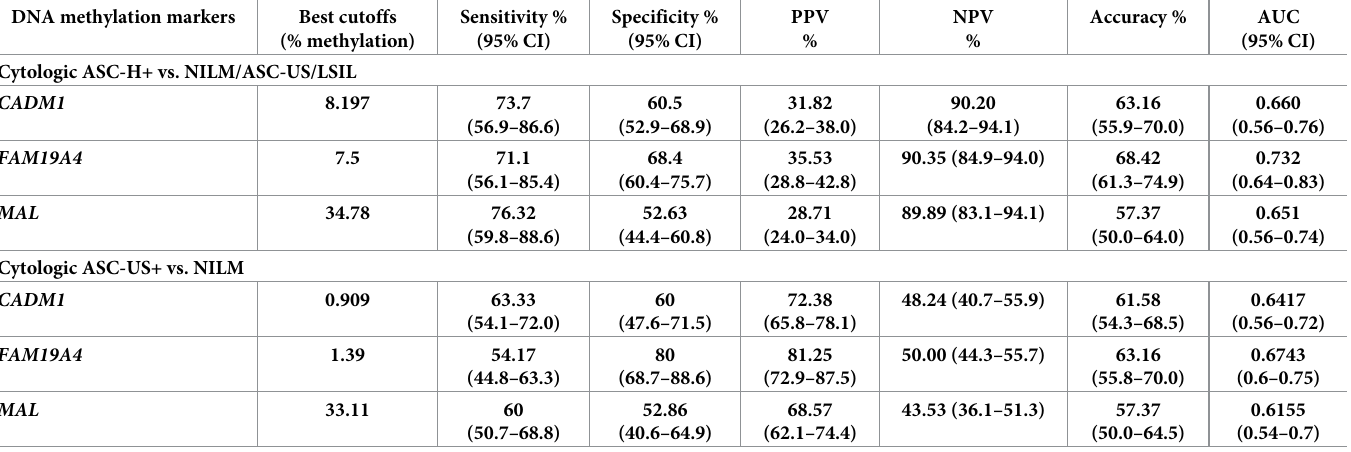
Table 5. The cutoff values of DNA methylation markers for distinguishing high-grade cytologic abnormalities (ASC-H+ vs. NILM/ASC-US/LSIL) and cytologic abnormalities (ASC-US+ vs. NILM) in HPV-positive women. DNA methylation markers Best cutoffs Sensitivity % Specificity % (% methylation) (95% CI) (95%